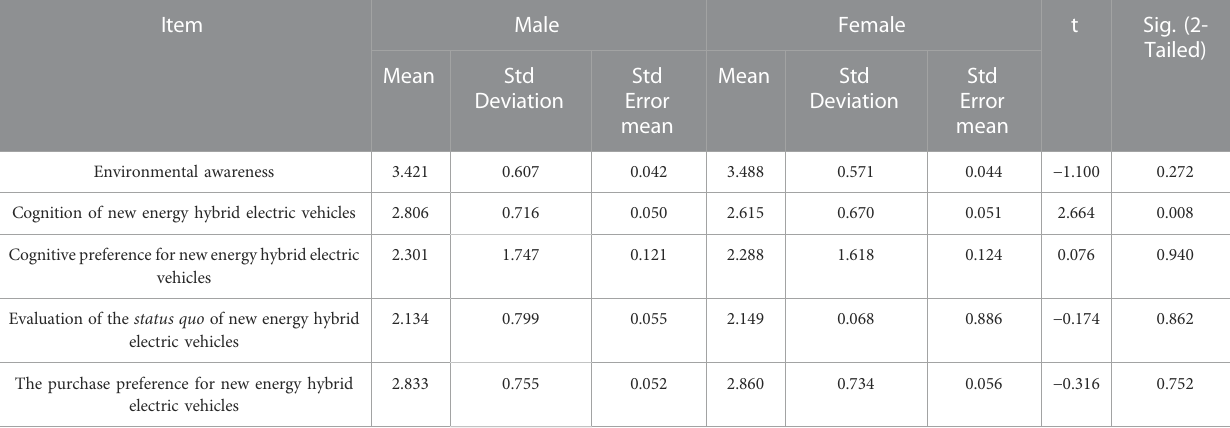
TABLE 11 T-test results of independent samples of different genders. Item Male